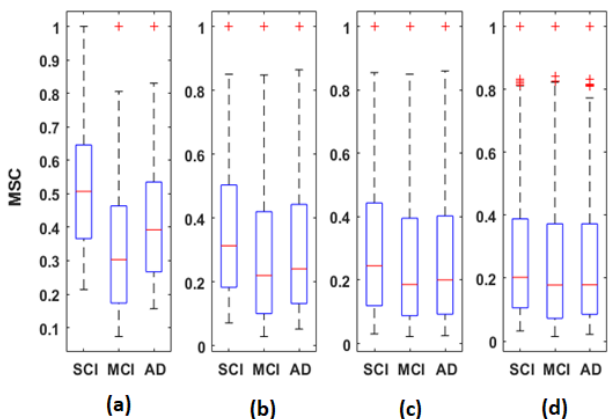
Figure 5. Boxplots of MSC values averaged over all subjects of the SCI, MCI and AD groups on the ( a ) delta, ( b ) theta, ( c ) alpha and ( d ) beta bands.